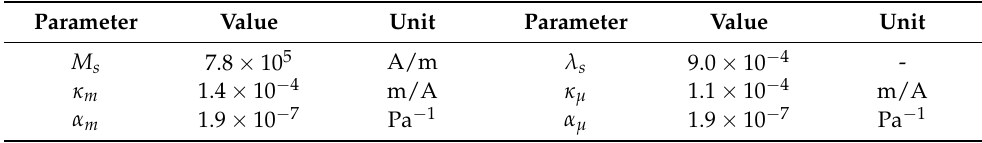
Table 2. Modelling parameters for the analytical